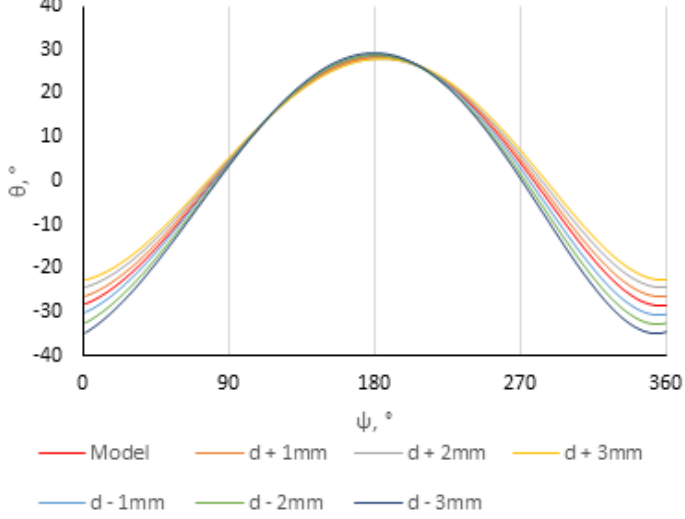
Figure 3. Influence of parameter d on the function curve.